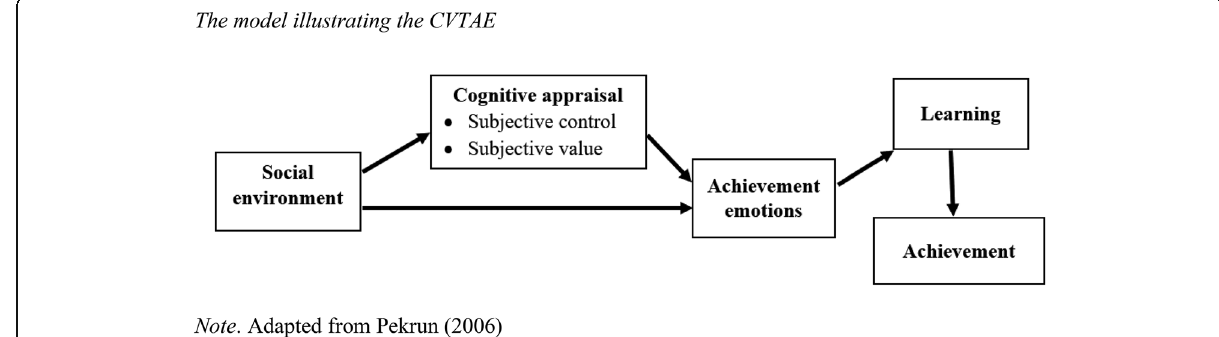
Fig. 1 The model illustrating the CVTAE. Adapted from Pekrun